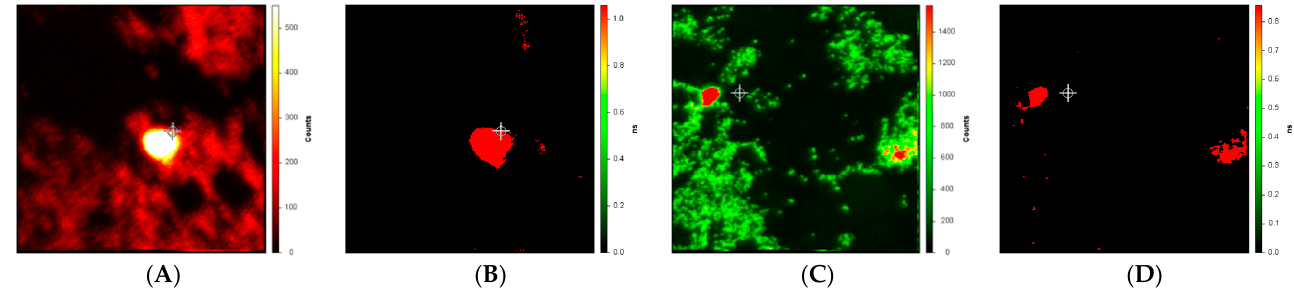
Figure 3. False color fluorescence intensity micrographs ( A , C ) and amplitude-weighted average fluorescence lifetime micrographs ( B , D ) of small drusen near the macula ( A , B ) and in the periphery ( C , D ) of the retina of a 79-year-old female (cause of death: dementia) stained by infusion with Cl-Tet. Conditions are as described in the legend to Figure 1 except that the background below less than 0.1% of peak intensity is not included in the lifetime images ( B , D ). Overall field size in all panels is 250 × 250 μ m.